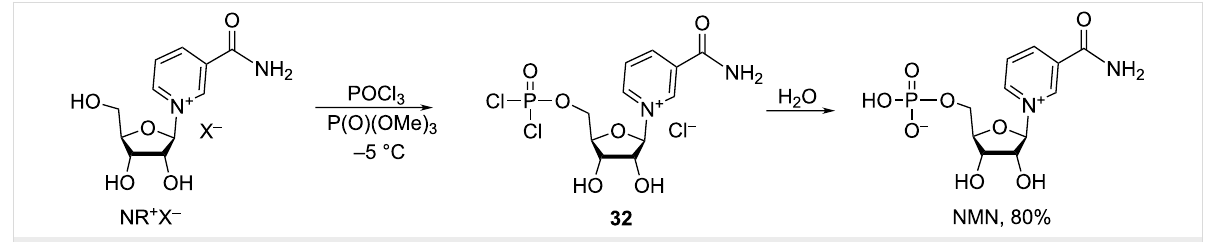
Scheme 17: Synthesis of NMN starting from NR +